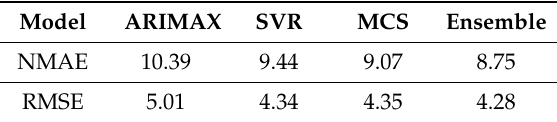
Figure 8. Forecast results of ensemble model (the x axis represents the 1 h intervals time for the evaluation period). Table 4. Accuracy of wind power